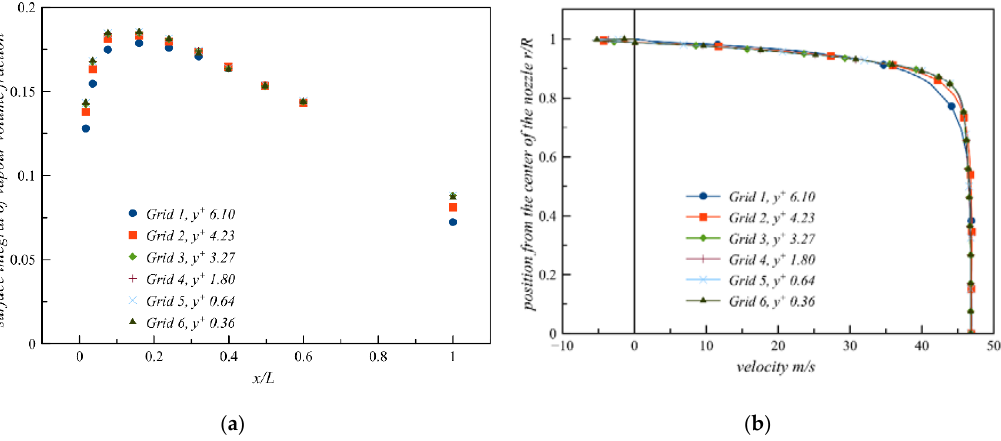
Figure 5. Grid sensitivity study: ( a ) vapor volume fraction across the nozzle at different axial positions along with the nozzle, ( b ) axial velocity distribution at x/L = 0.0167.